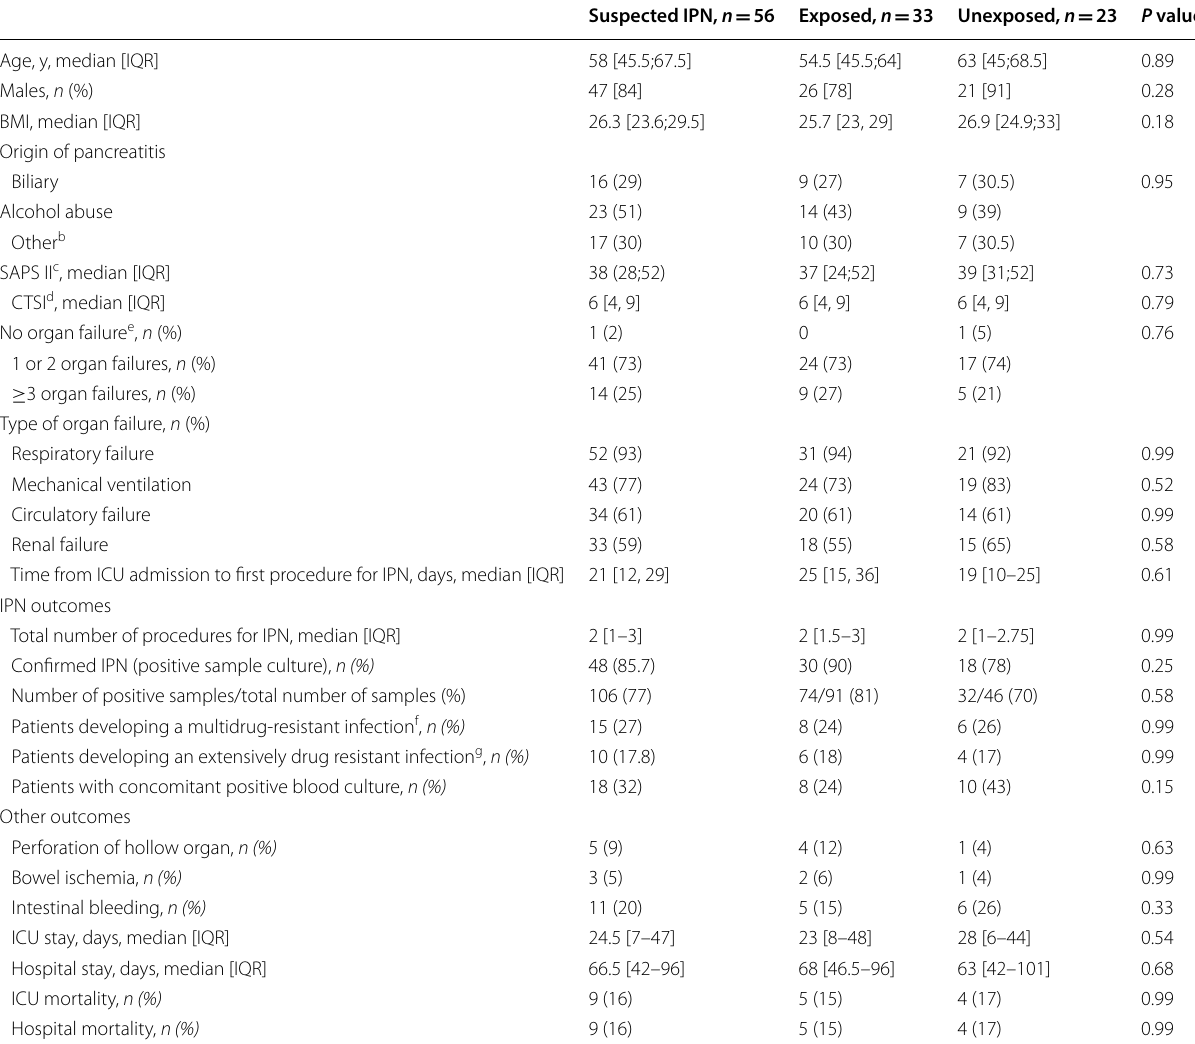
Table 1 Baseline features of the study patients overall and in the antibiotic-exposed and unexposed groups